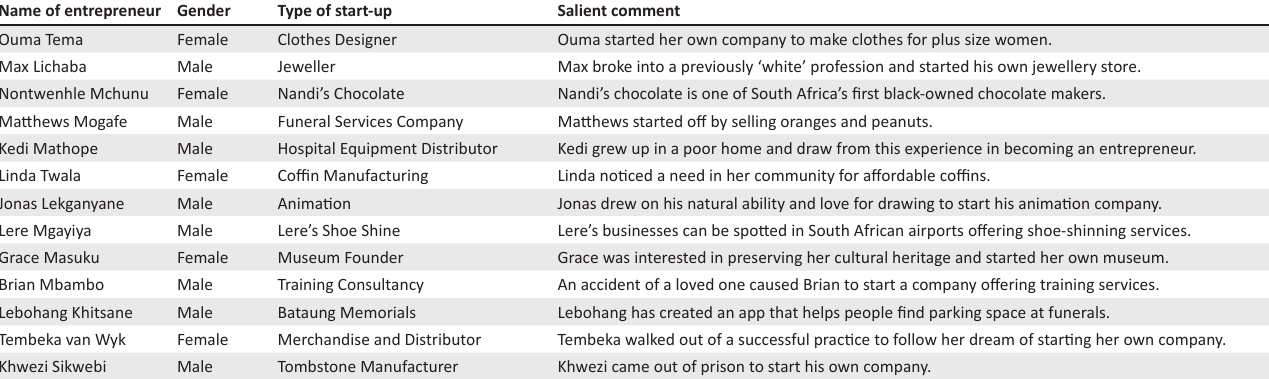
TABLE 2: Participants to the research. Name of entrepreneur Gender